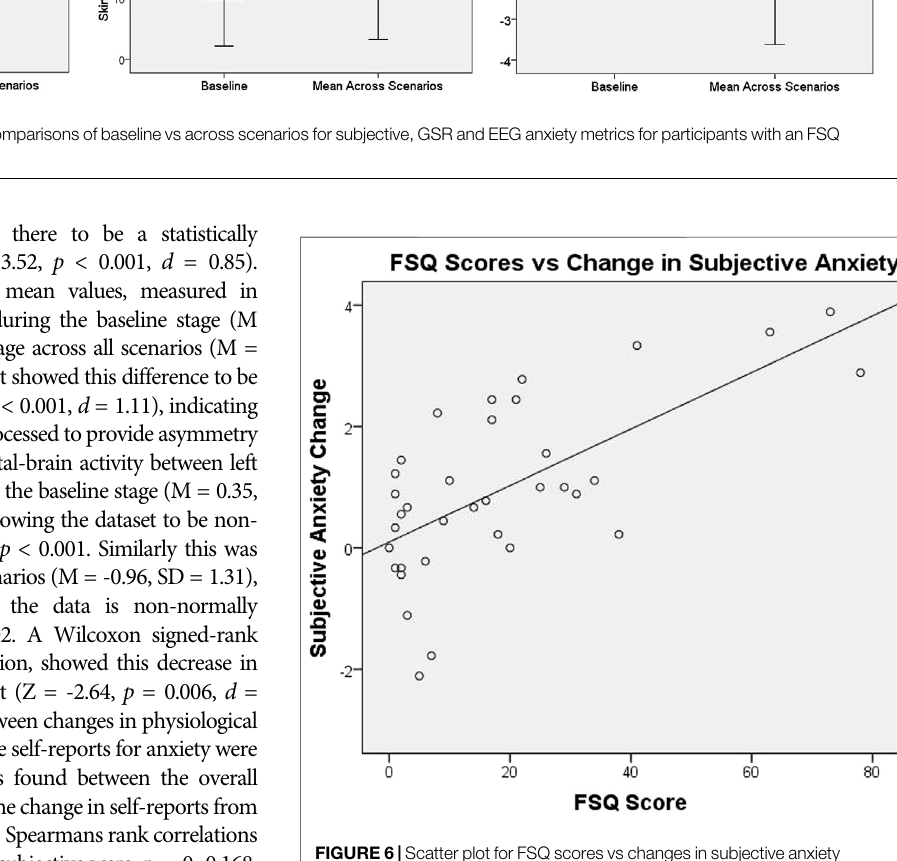
Frontiers in Virtual Reality |